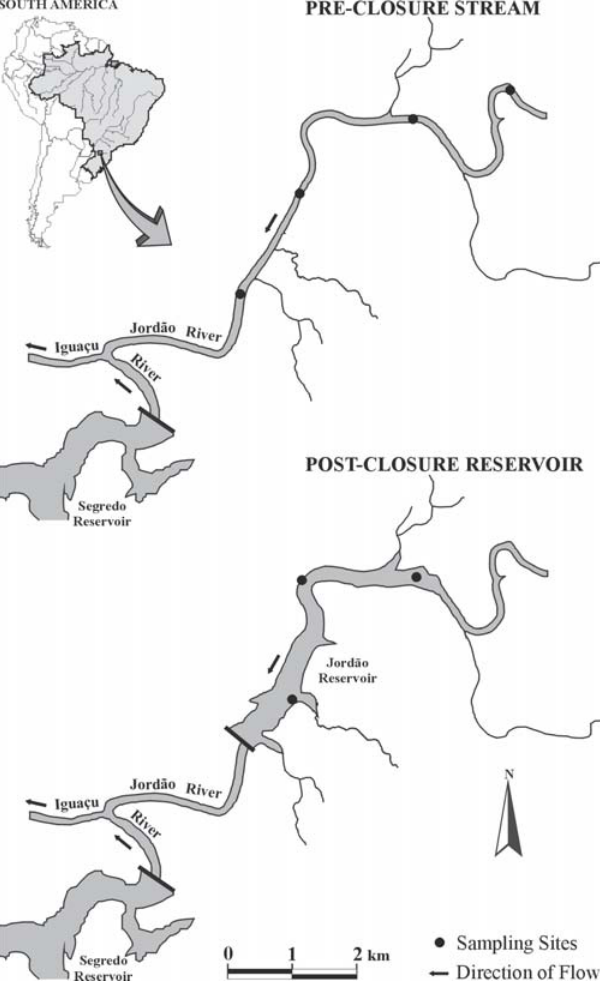
Fig. 1. Geographical location of Jordão River (Paraná State, Brazil) with indication of the